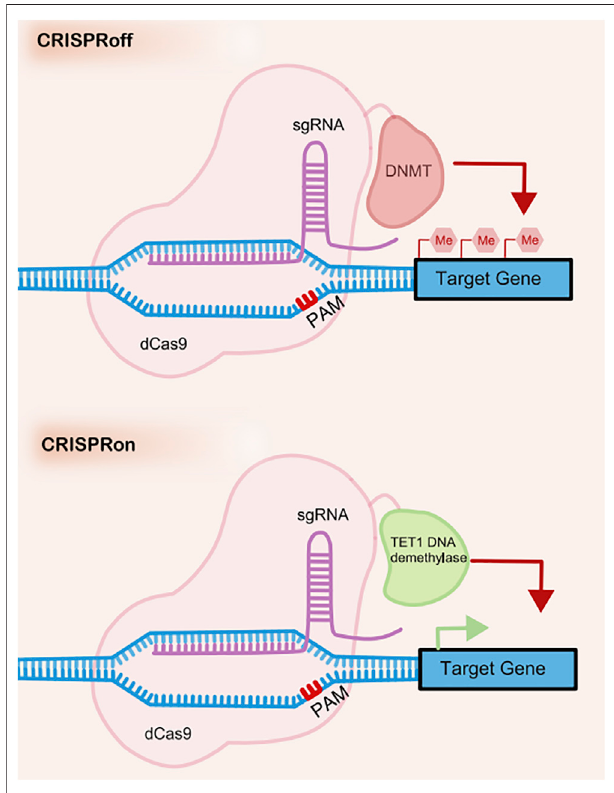
FIGURE 3 | The mechanism of CRISPRoff and